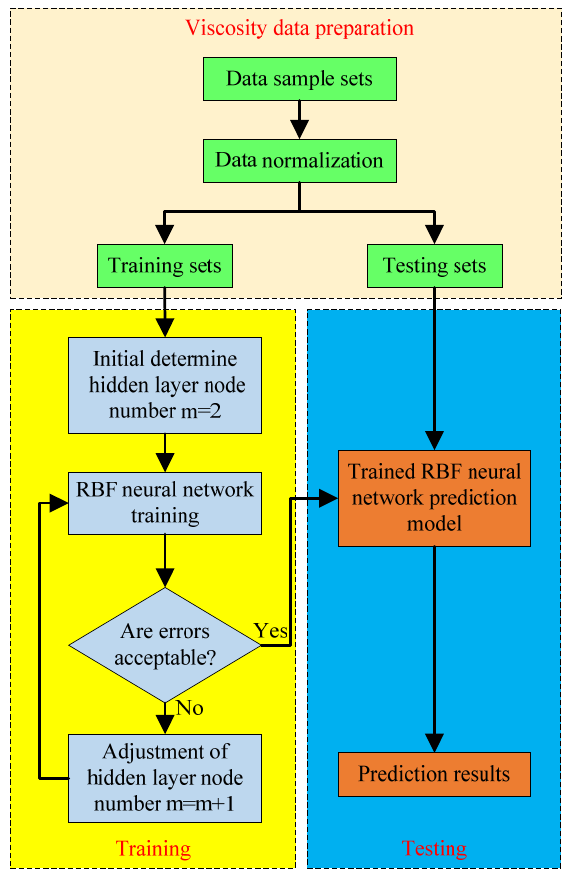
Figure 2. Implementation process of a RBF neural network for viscosity prediction.